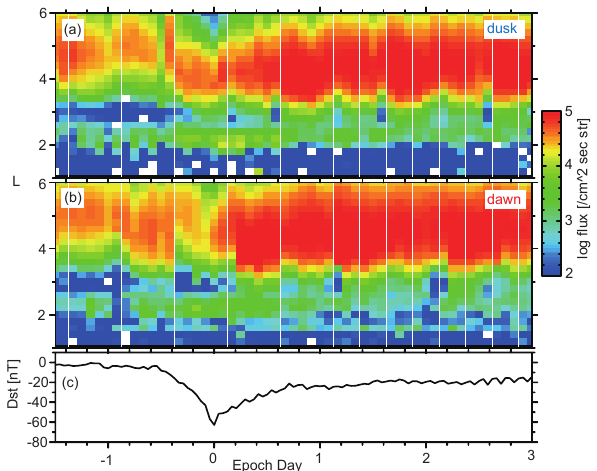
Fig. 5. (a) L-t diagram of electron flux variations in the radiation belt from the 157 to 163 days of 1992. (b) The K p index. (c) The D st